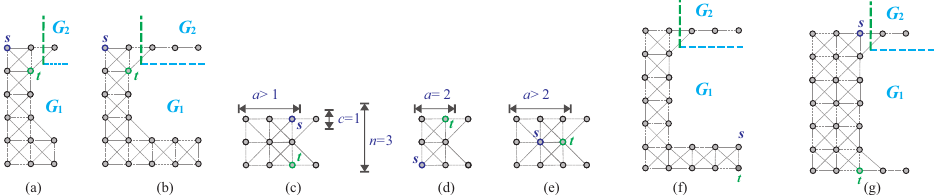
Figure 23. The cases for s , t ∈ G 1 and { s , t } is not a vertex cut of G 1 , where ( a , b ) a = 2, s y , t y (cid:54) 2, s y (cid:54) = t y , and s x (cid:54) = t x , ( c – e ) ( C ( m , n ; k , l ; c , d ) , s , t ) satisfies condition (F8), and ( f , g ) ( G 1 , s , t ) satisfies condition (F3) but it does not satisfy condition (F1).